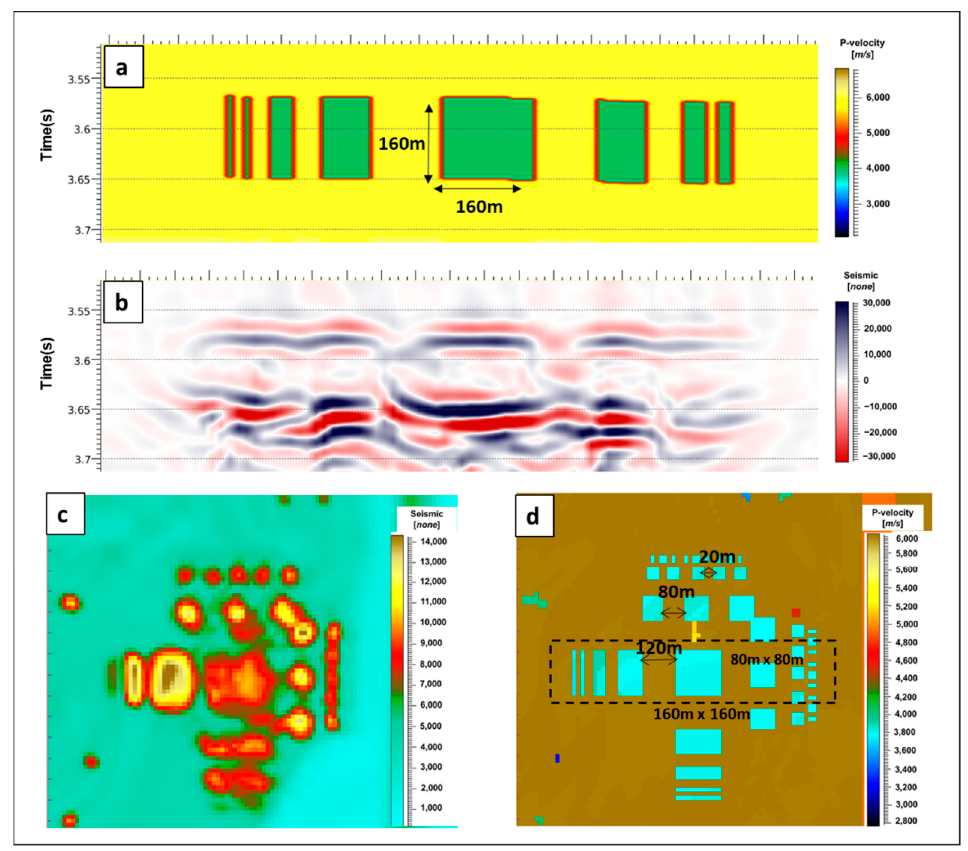
Figure 3. Model of complicated combination caves. Geological model 3: ( a , d ) geological models; ( b ) seismic models; ( c ) Seismic RMS amplitude map.